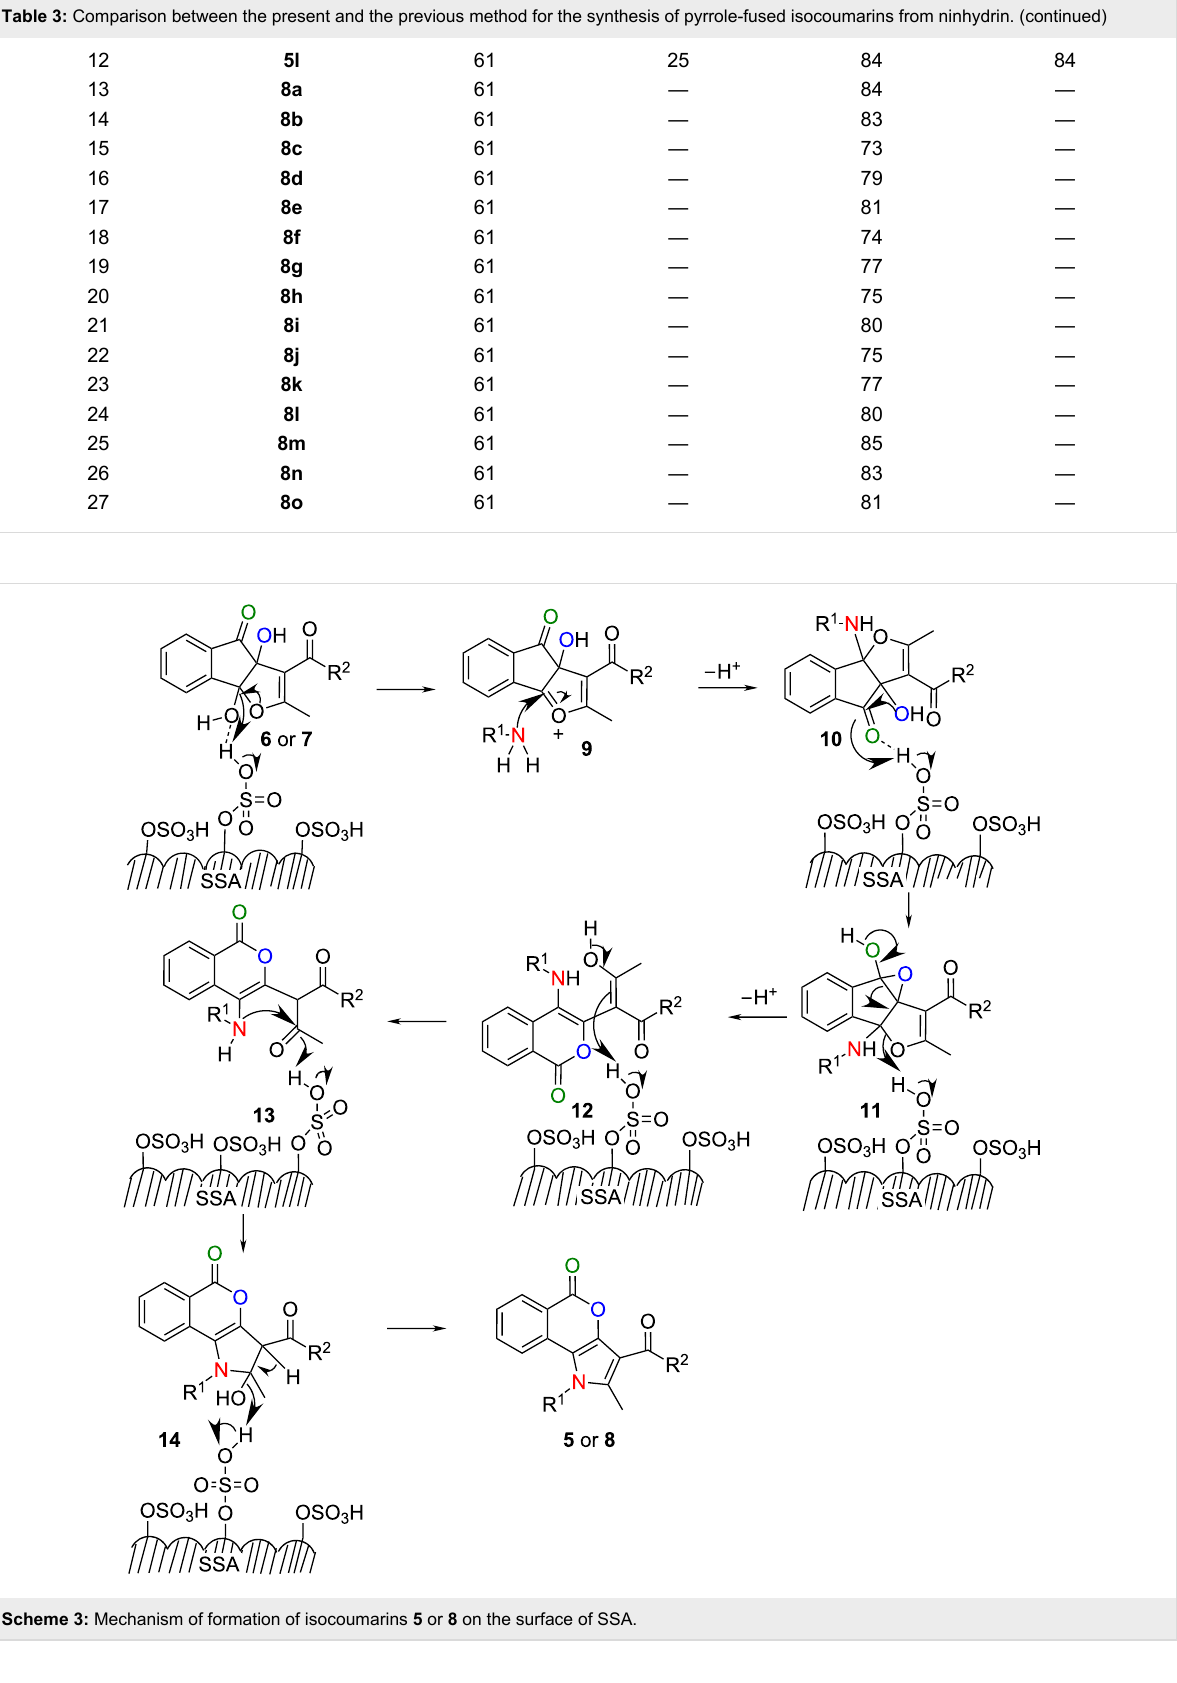
Table 3: Comparison between the present and the previous method for the synthesis of pyrrole-fused isocoumarins from ninhydrin. (continued)